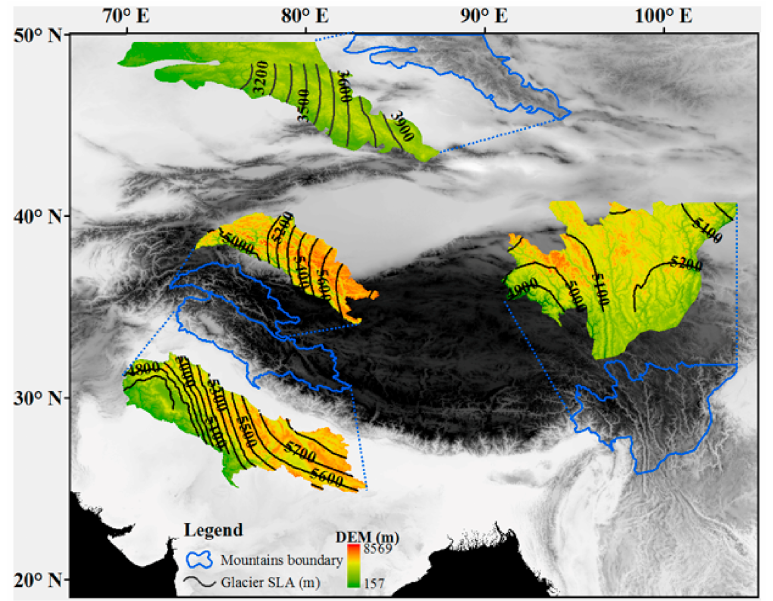
Figure 15. Glacier SLA variations across different mountainous regions of the Tibetan